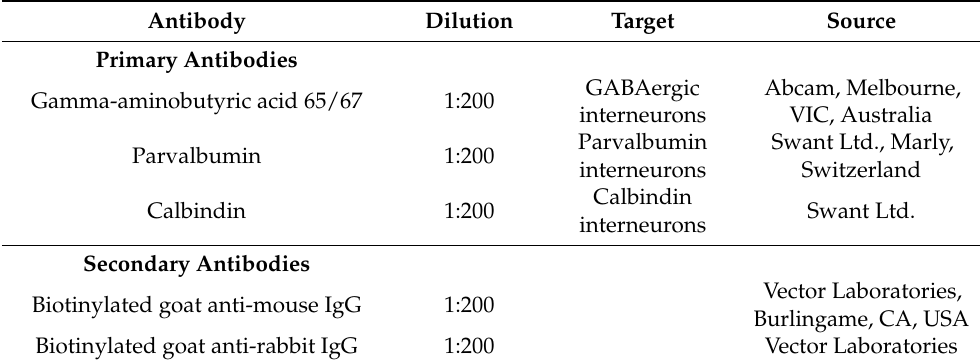
Table 1. Antibodies and markers used for